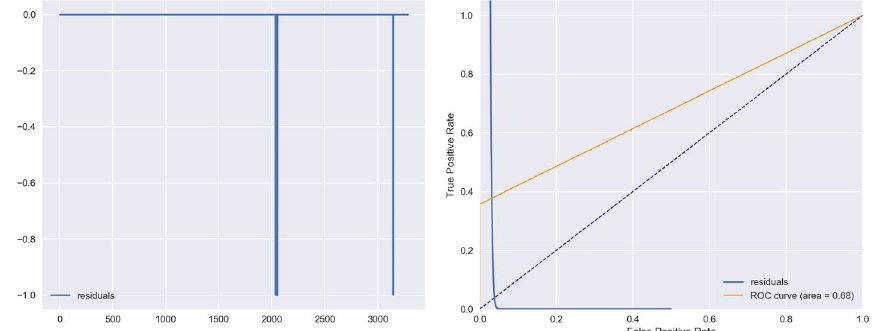
Fig. 9 Results of applying TabNet to D21 only. Left: residual sequence with original timed order. Right: ROC curve and residual distribution